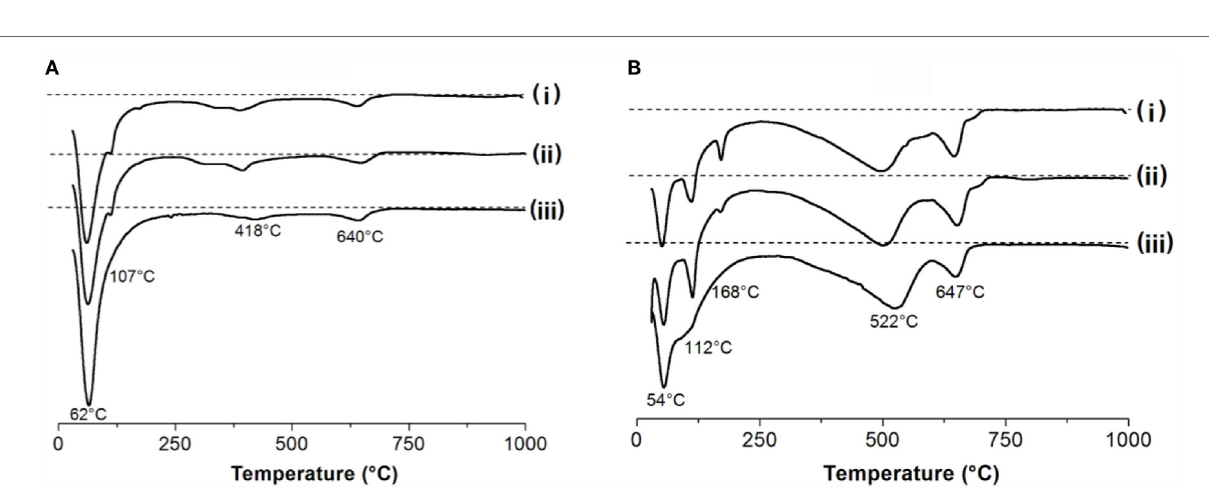
FigUre 2 | Thermogravimetry curves and differential thermograms of (a) non-carbonated and (b) accelerated-carbonated alkali-activated pasted with a gbFs/(gbFs + MK) of (i) 1.0, (ii) 0.9, and (iii) 0.8